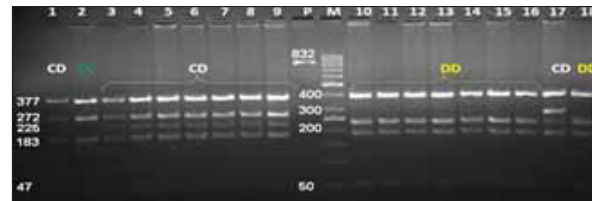
Figure-4: Polymerase chain reaction (PCR) restriction fragment length polymorphism analysis of 832 bp target region of cluster of differentiation 14 (CD14) using Hinf I restriction enzyme in Karan Fries cows. Lane 2: CC (372, 272 and 183 bp), Lane 1, 3-9, 17: CD (377, 272, 225, 183, 47 bp), Lane 10-16, 18: DD (377, 225, 183, 47 bp), P: PCR product (832 bp), M: 50 bp DNA